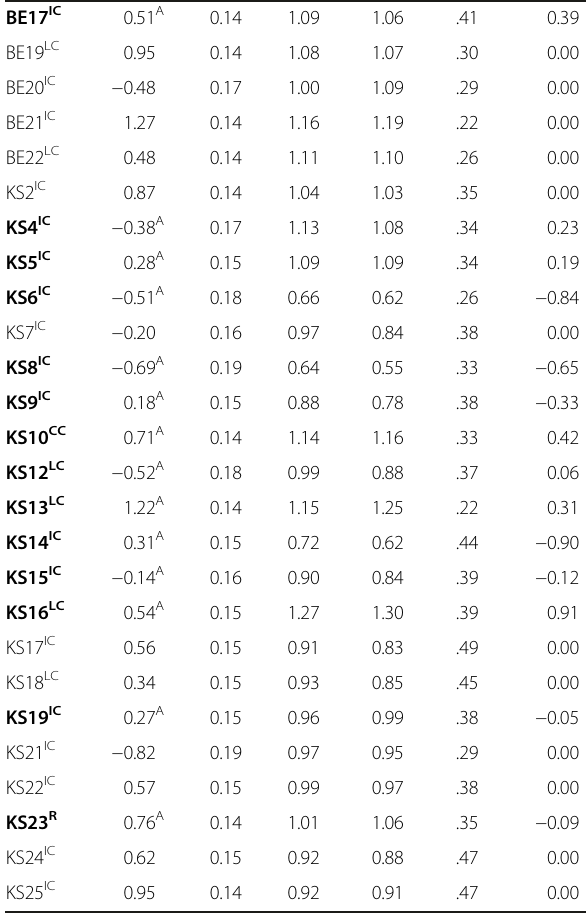
Table 7 Psychometric properties of the items of the TRC-e-4 (69 items)